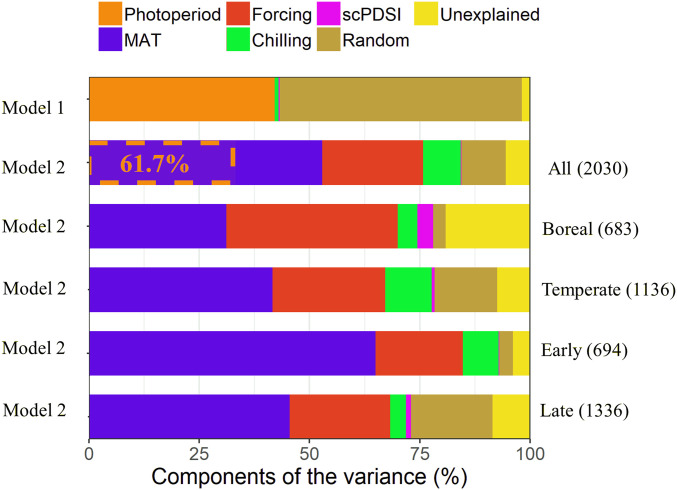
Variance partition of the studied variables. Fixed variables include photoperiod, forcing, chilling days, and scPDSI in model 1 (DOY ∼ photoperiod + forcing + chilling + scPDSI), and MAT (represented by mean annual temperature), forcing, chilling days, and scPDSI in model 2 (DOY ∼ MAT + forcing + chilling + scPDSI). Random variables include species and sites. Model 2 was applied to all trees and separately to trees within each group (the boreal and temperate biomes, and the early and late successional species). The values in the brackets represent the number of observations for the corresponding group. The value in the rectangles with dashed borders refers to the proportion of variance in MAT explained by photoperiod.